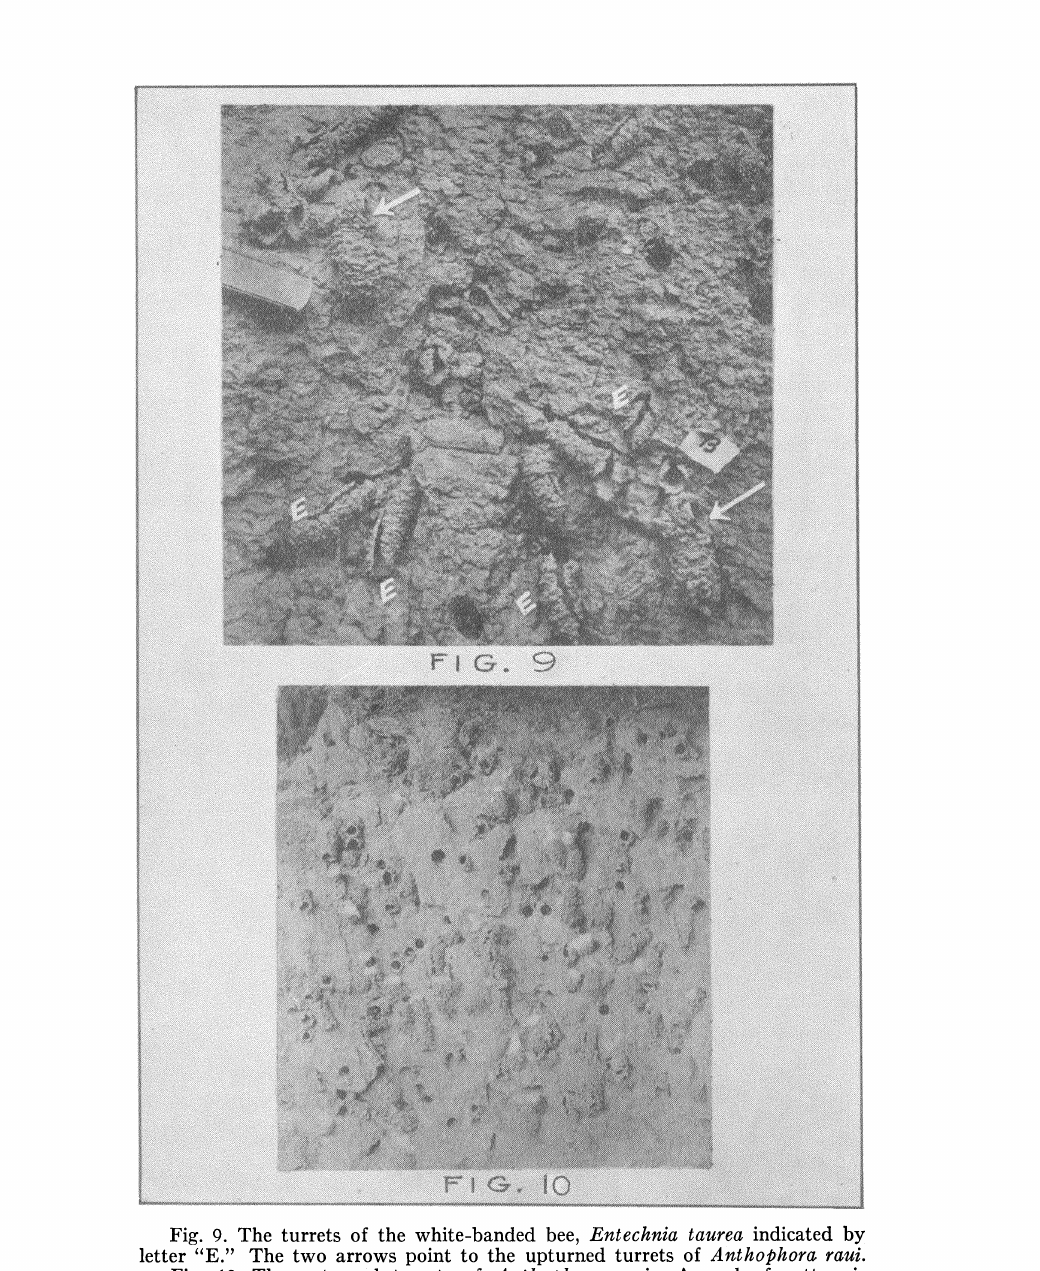
Fig. 9. The turrets of the white-banded bee, Entechnia taurea indicated by letter "E." The two arrows point to the upturned turrets of Anthophora raui. Fig. 10. The upturned turrets of Anthophora raui. A wad of cotton is placed in the opening of some of the turrets to show their upturned